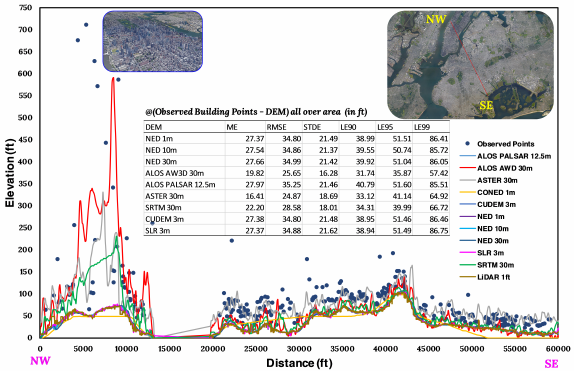
Figure 11. Topographic profile of all topography models with observed building elevations, Satellite